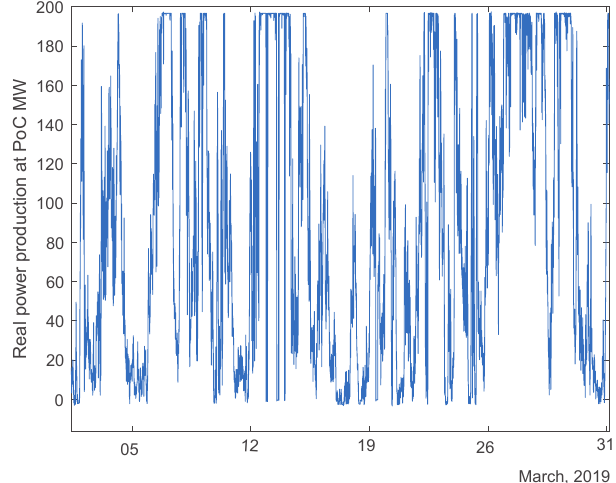
Figure 5. Simulated real power production at the PCC for a March month. The active power injection of the wind turbines mainly depends on the wind speed. The real power production at PCC and real power losses within the wind park with respect to wind sweep speeds are shown in Figure